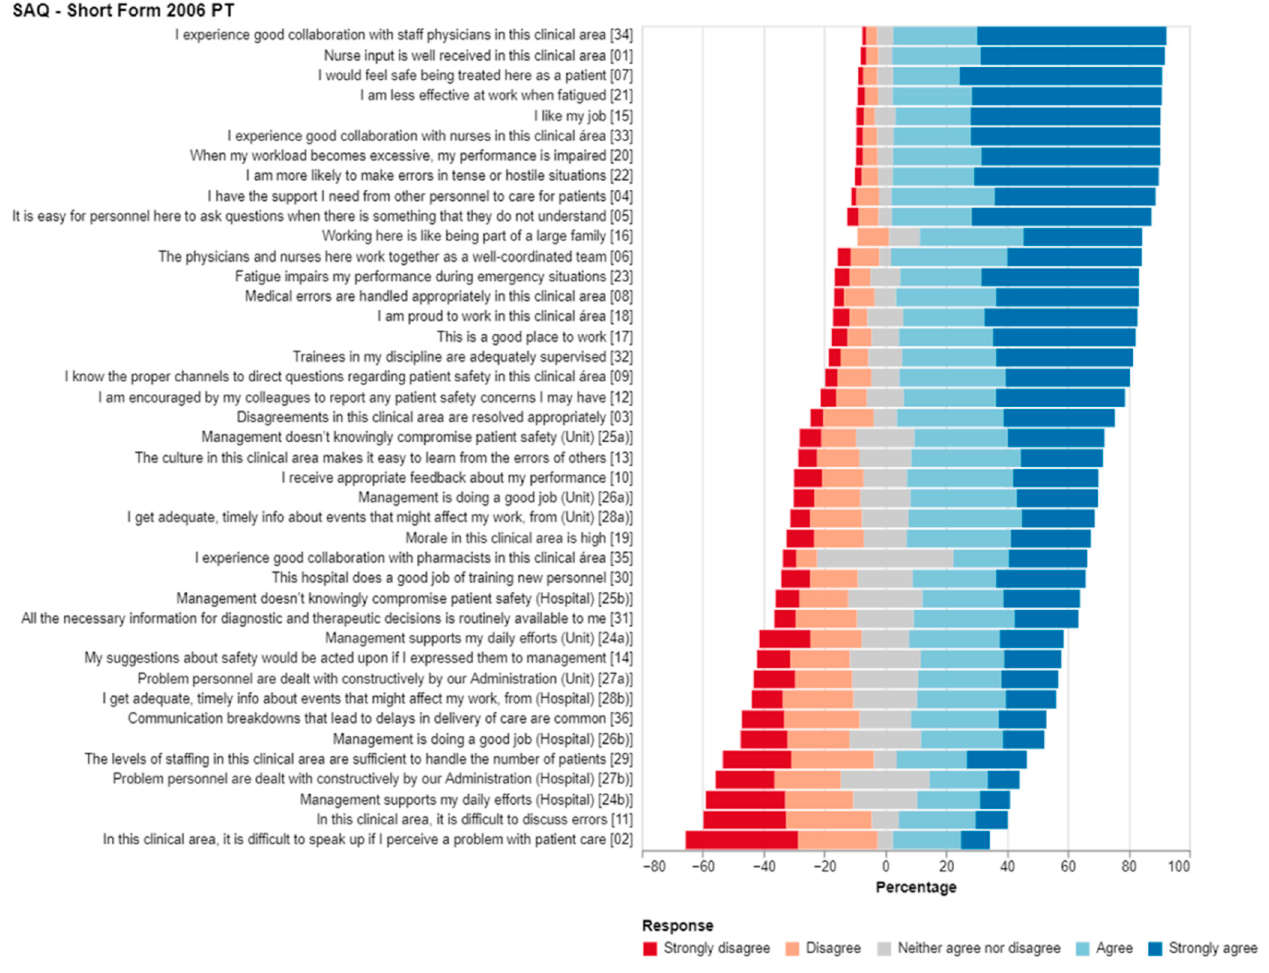
Figure 1. Descriptive Analysis of the SAQ—Short Form 2006 PT per item. The 41 SAQ-Short Form 2006 PT items and respective Likert scale responses are presented (without inversion of items 2, 11 and 36). In order to improve the completion of the questionnaire by PHC professionals, three references were added to SAQ-Short Form 2006 PT (Google Forms version), defining equivalence between terms: hospital = ACeS, unit = UCSP/USF and clinical area = UCSP/USF.